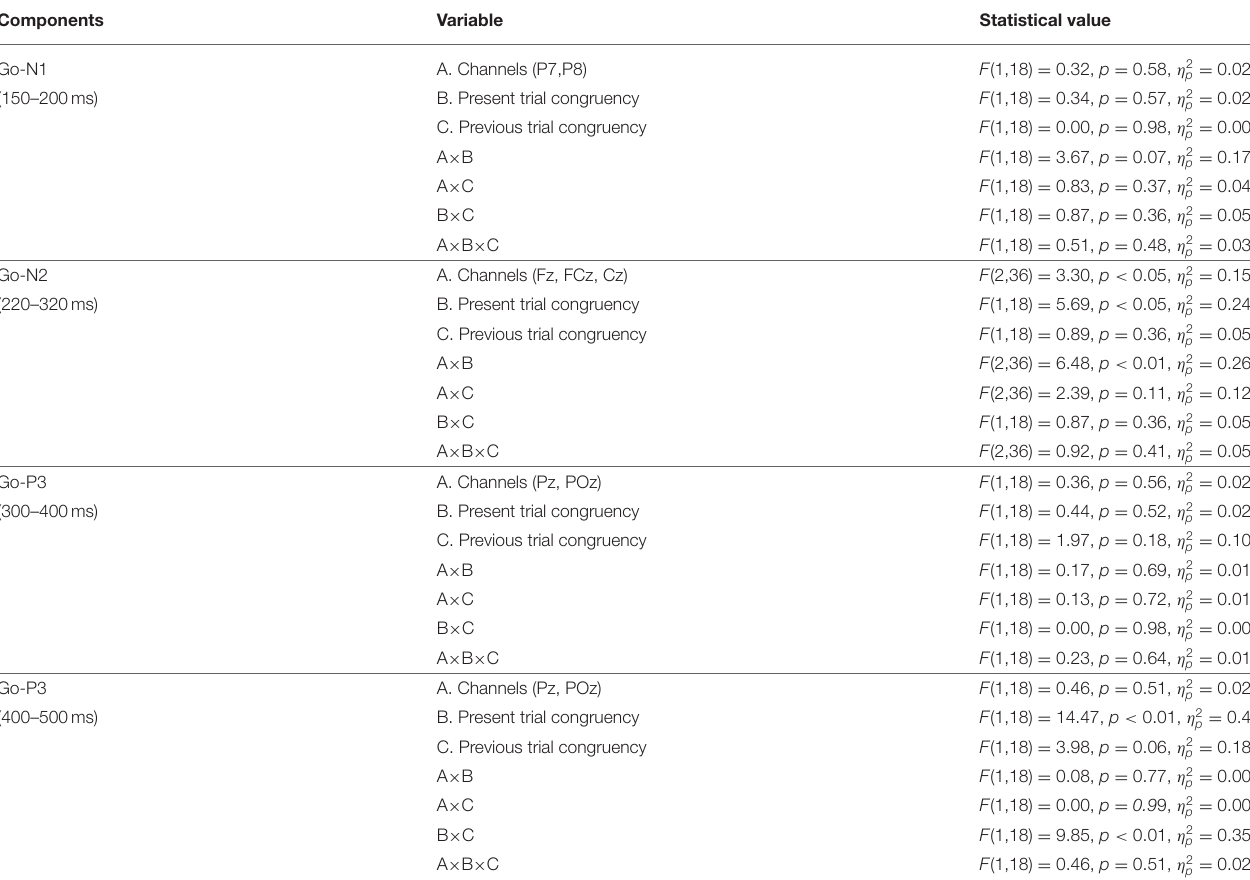
TABLE 2 | The results of ANOVA of ERP components for Go-stimuli.